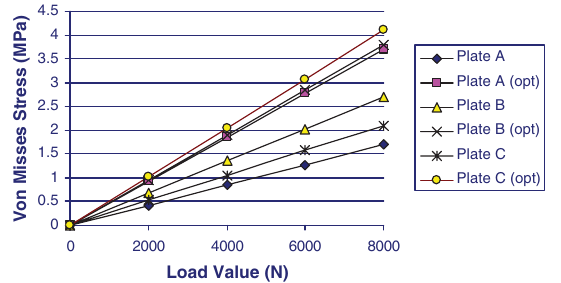
Fig. 10. Variation of Stress with Applied Load Before and after Optimization.